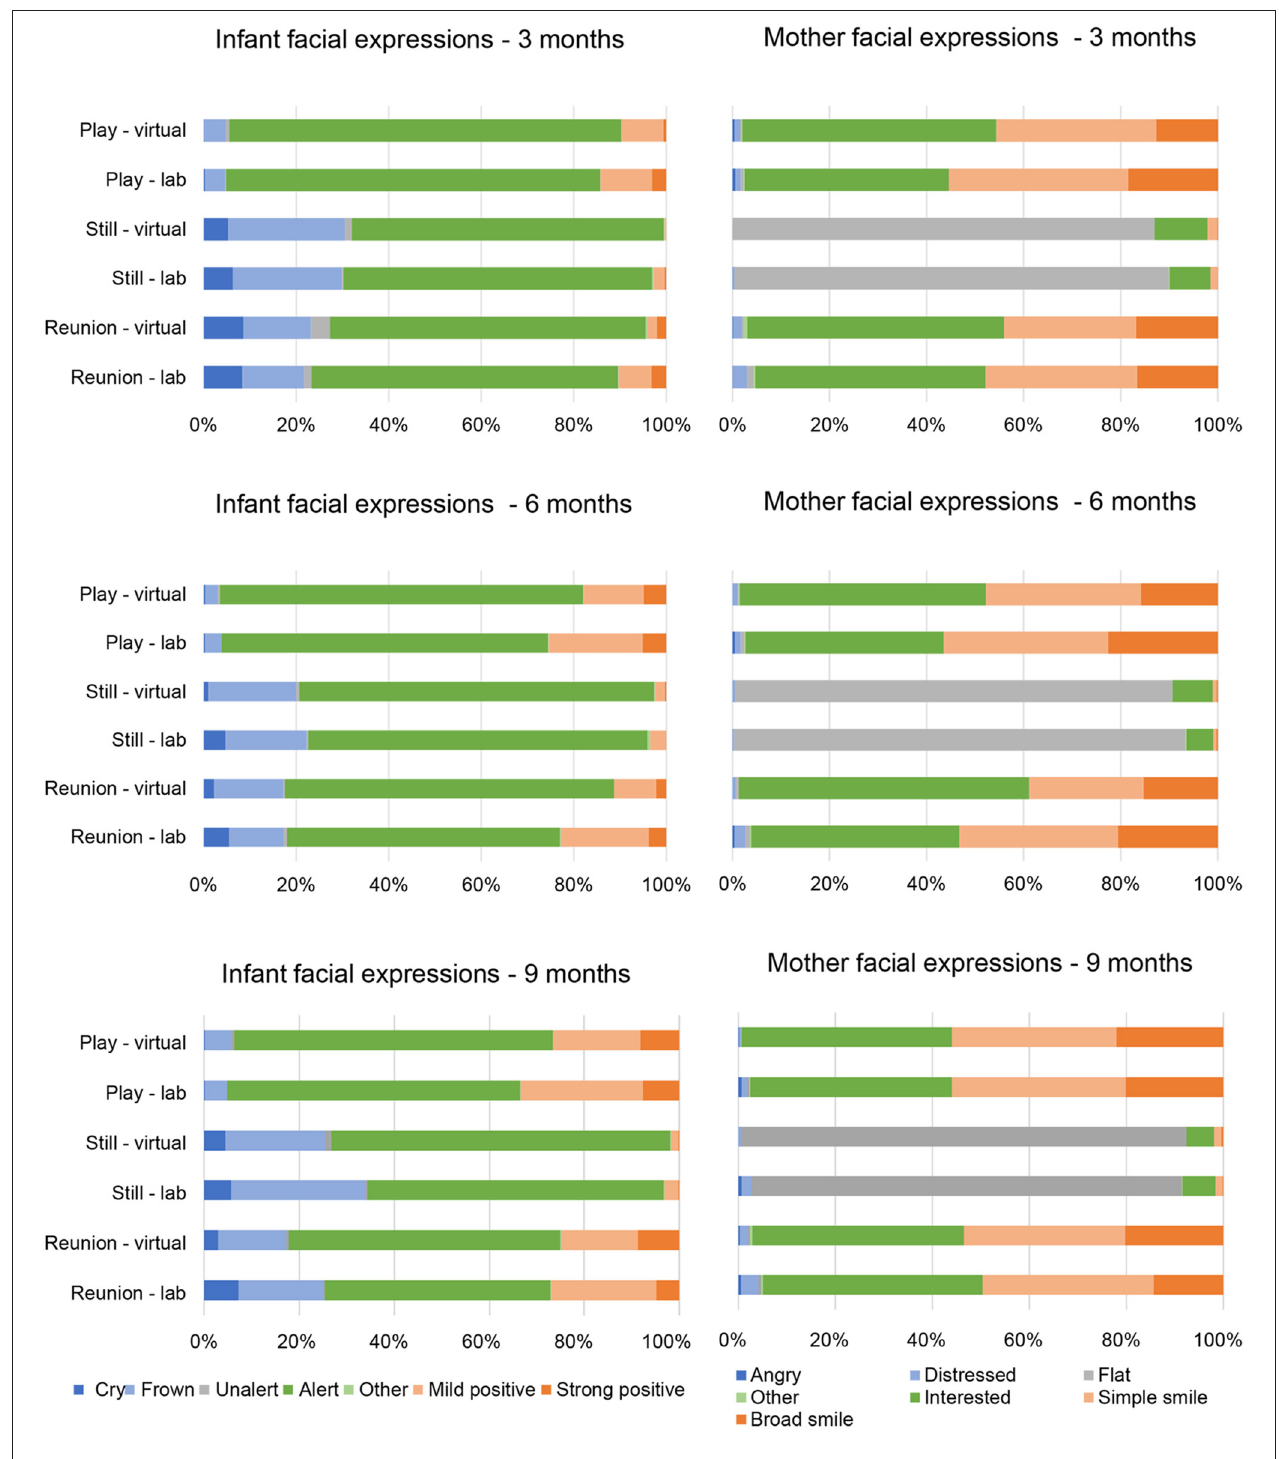
FIGURE 1 | Infant and mother facial expressions by Still Face episode, visit type and time point.